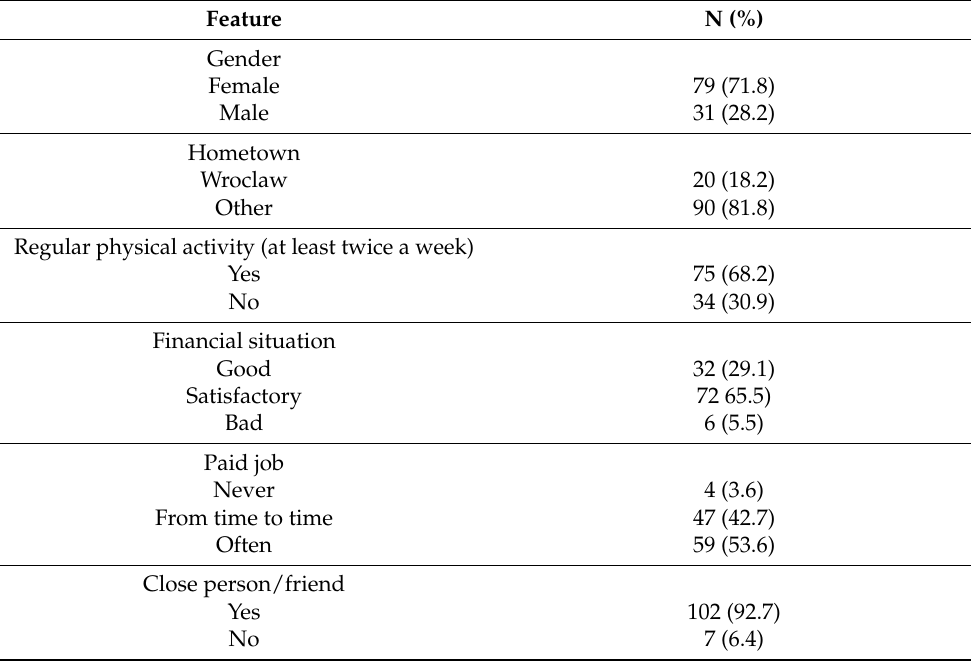
Table 1. Characteristics of the study group (N =